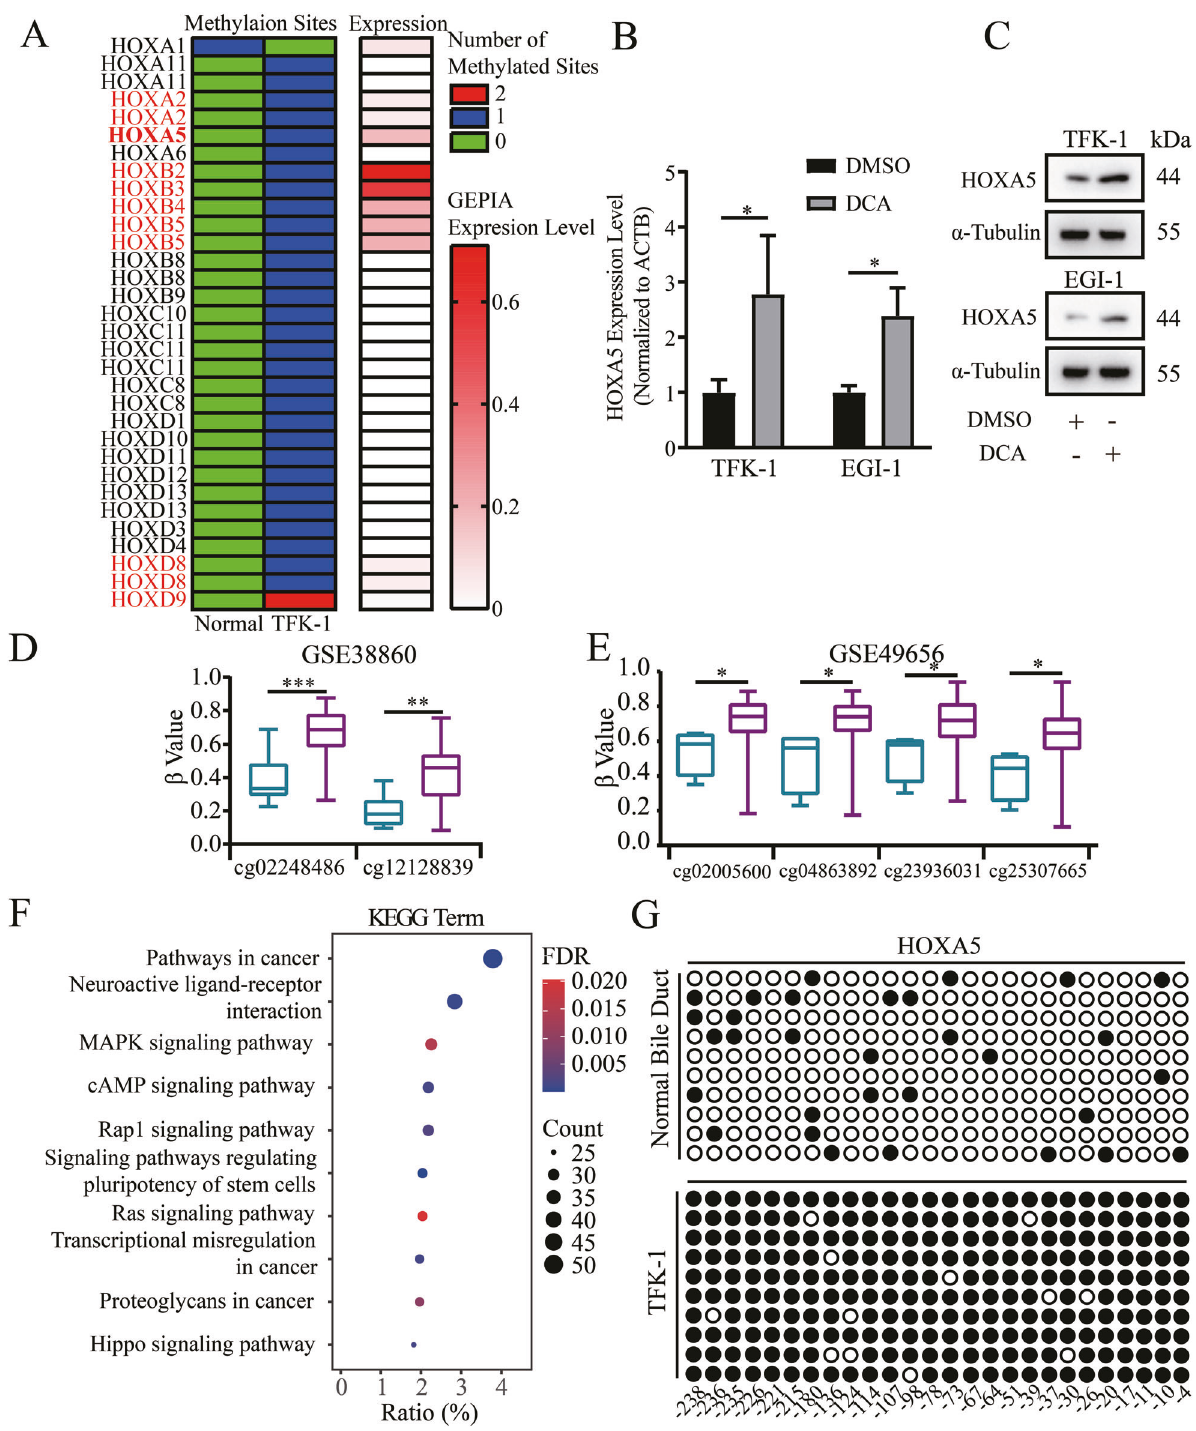
Fig. 1 The methylation pro fi le of the HOXA5 gene in ECCA. A Heatmap analysis of the methylation and expression level of the HOX genes. The gradual changes from red to white represent changes in gene expression from high to low. Green, no CpG island. Blue, 1 CpG island. Red, 2 CpG islands. B , C RT-qPCR and Western blot analyses of HOXA5 expression in ECCA cells following treatment with, or without, DCA. D , E Analysis of the methylation pro fi le of the HOXA5 gene in GSE49656 and GSE38860 of GEO database. The purple box represents the cancer samples and the blue box represents the non-tumor samples. F Bubbles plotted the KEGG analysis of the methylation levels of differential genes. The gradual changes from red to blue represent the changes in high to low FDR. The sizes of bubbles represent the numbers of genes enriched in certain terms. G The methylation pro fi le of the HOXA5 gene from the BSP results. The black solid represents methylated sites and the hollow points represent unmethylated sites. * P < 0.05. ** P < 0.01. *** P < 0.001.